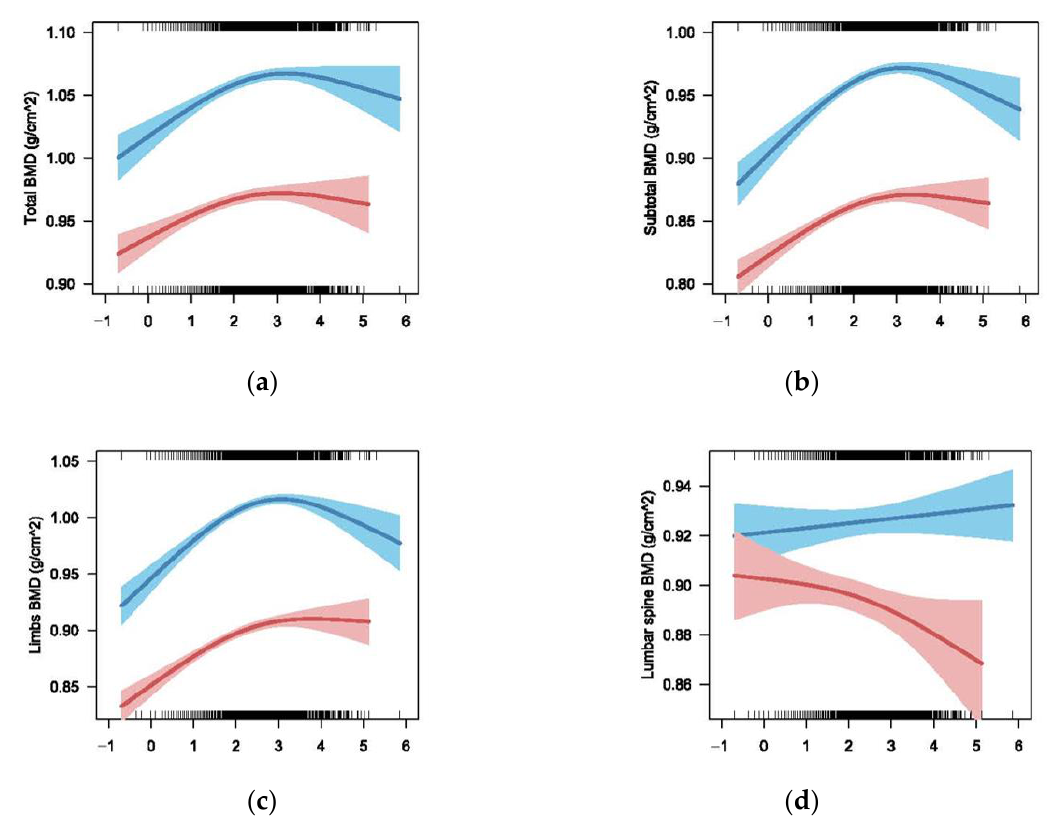
Figure 4. Multivariate models for ln-transformed BLLs on total BMD, subtotal BMD, limb BMD and lumbar spine BMD stratified by sex (blue line for male and red line for female) adjusted for age, race/ethnicity, height, weight, family-income-to-poverty ratio and blood cadmium, with results weighted for sampling strategy: ( a ) Total BMD: F = 29.87, p < 0.001, R-sq.(adj) = 0.77 for male; F = 20.38, p < 0.001, R-sq.(adj) = 0.731 for female; ( b ) Subtotal: F = 62.11, p < 0.001, R-sq.(adj) = 0.819 for male; F = 48.13, p < 0.001, R-sq.(adj) = 0.761 for female; ( c ) Limb BMD: F = 64.33, p < 0.001, R-sq.(adj) = 0.826 for male; F = 68.42, p < 0.001, R-sq.(adj) = 0.754 for female; ( d ) Lumbar spine: F = 0.917, p = 0.338, R-sq.(adj) = 0.689 for male; F = 2.965, p = 0.035, R-sq.(adj) = 0.663 for female.